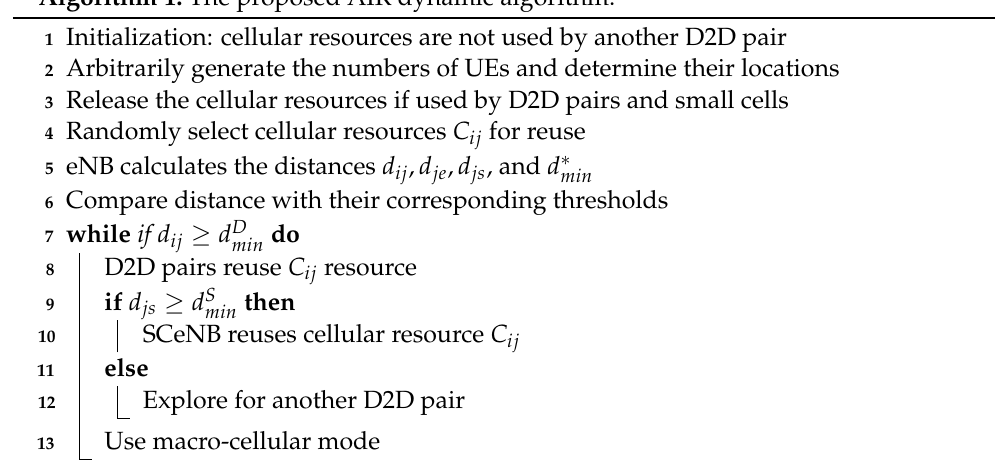
Algorithm 1: The proposed AIR dynamic algorithm.